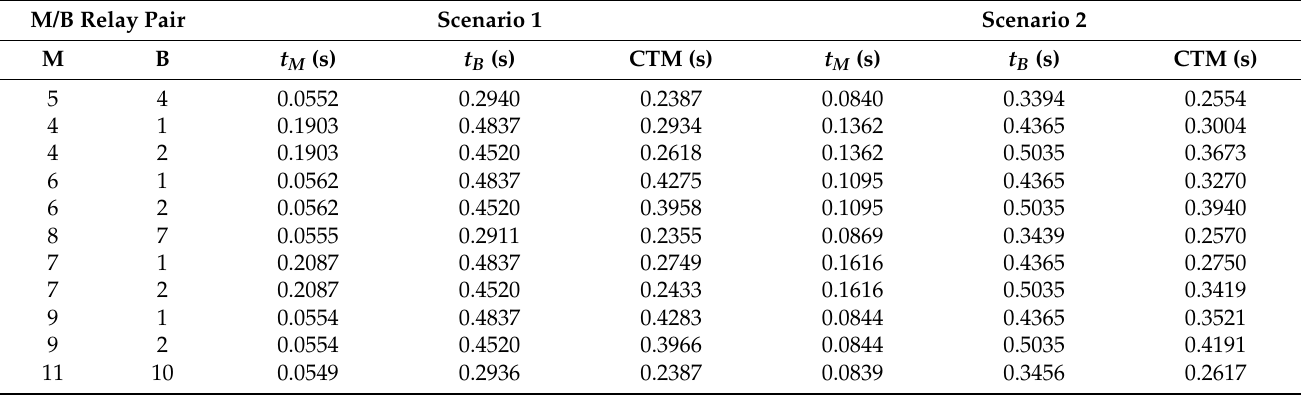
Table 15. Coordination check of Test Model